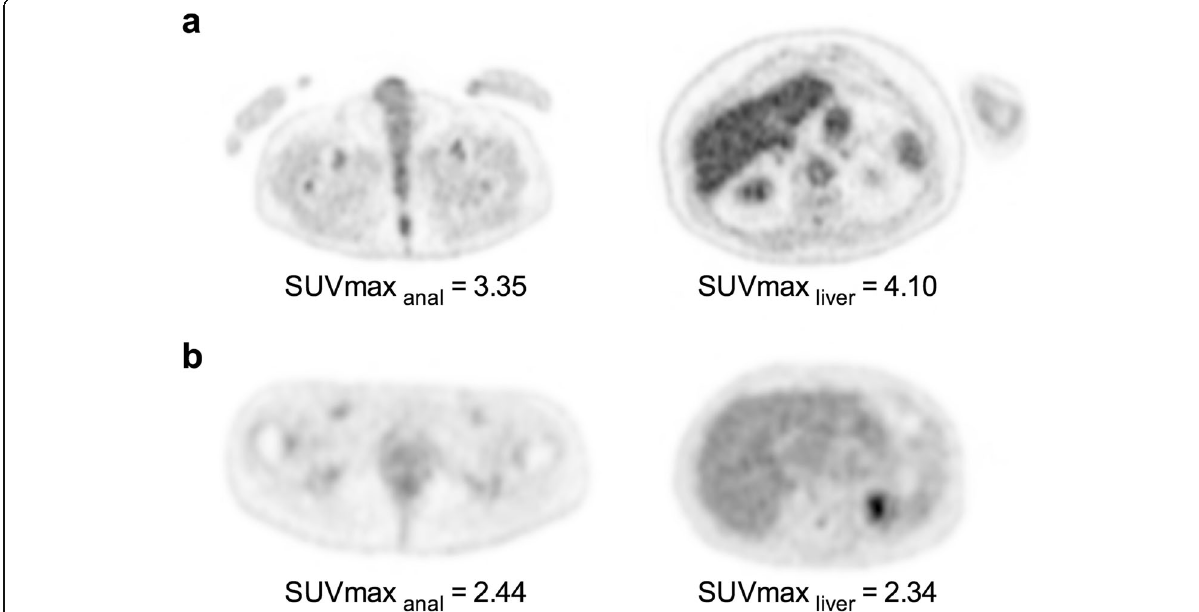
Fig. 5 Axial EARL-accredited images centered on the anal canal (left panel) and the liver (right panel) of a patient classified with significant anal canal hypermetabolism on visual analysis who would be classified “ negative ” using liver uptake as reference ( a ) and a patient classified with basal anal canal hypermetabolism who would be classified as “ positive ” using liver uptake as reference ( b